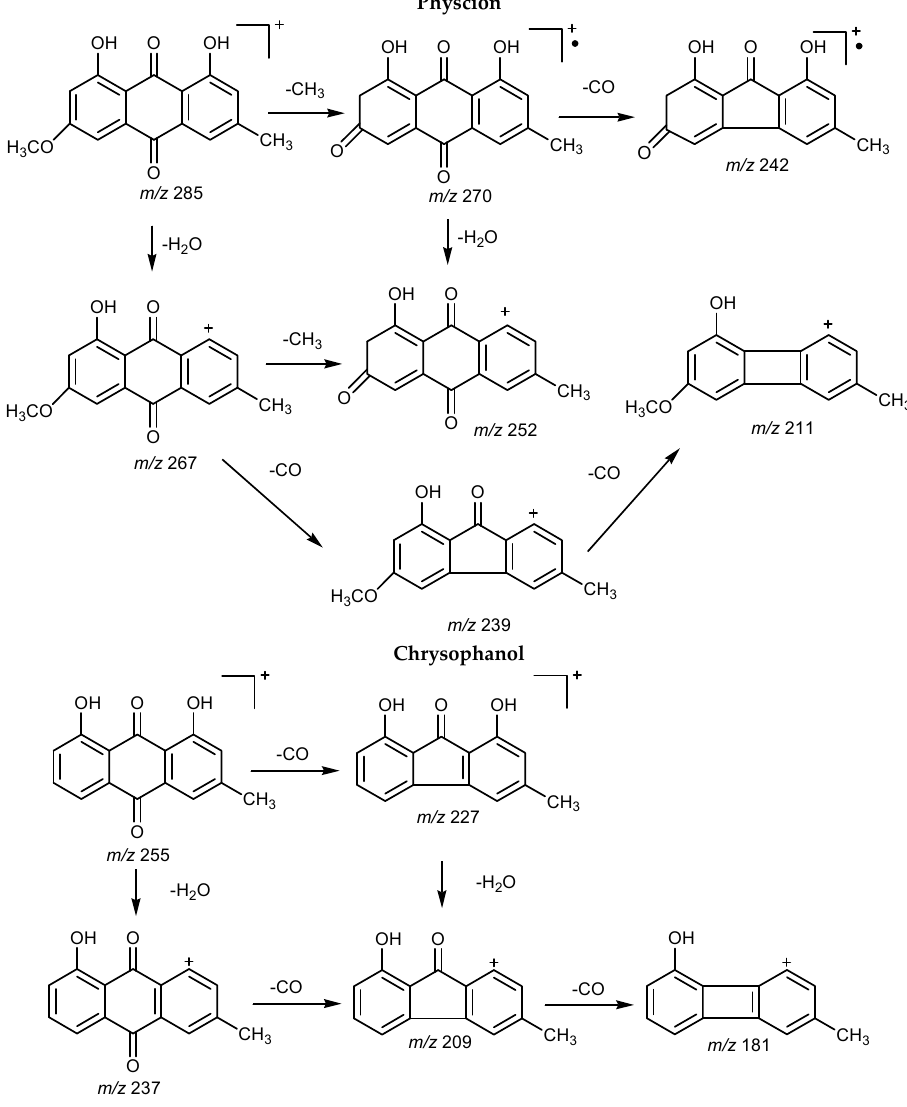
Figure 2. Proposed MS/MS fragmentation pathways of five free anthraquinones standard references. Four glycosyl anthrone standards, i.e. , sennoside A, sennoside B, sennoside C, and aloin, were